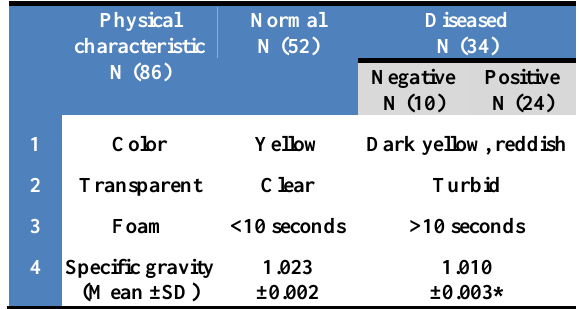
Table, 1: Physical examination of urine samples of slaughtered buffaloes.